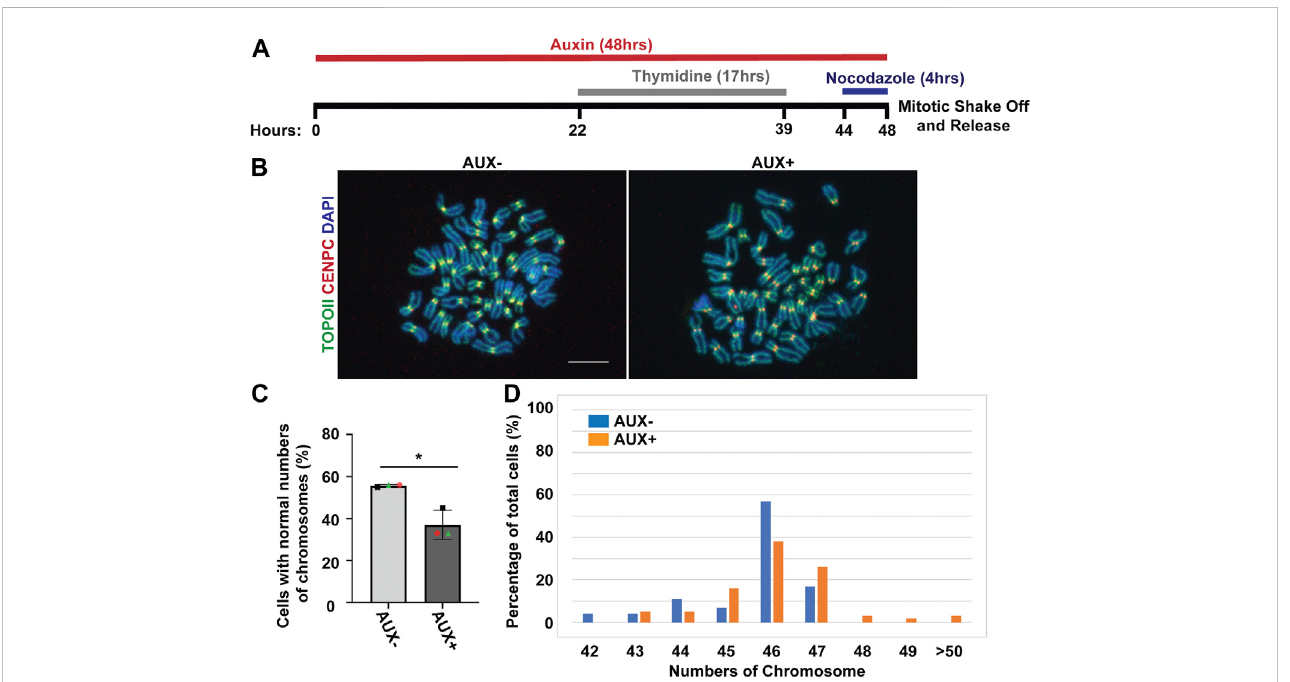
FIGURE 6 The EWSR1 knockdown promotes the induction of aneuploidy. (A) . Schematic diagram for the mitotic synchronization of AID-EWSR1 knockdown (synchronized to mitosis using thymidine/nocodazole, and treated with AUX for 48 h concurrently) cells. The mitotic cells were harvested 30 min after released from the arrest. (B) . Representative images of chromosomes visualized with anti-CENP-C (red), and anti-Topoisomerase II (green) obtained from AUX- and AUX + cells. Scale bar = 10 um. (C) . The percentage of cells that displayed normal 46 numbers of chromosomes was decreased in AUX + cells compared to AUX-cells. 18-24 cells per sample were counted from n = 3 experiments (Total of n = 56 cells from AUX-, and of n = 62 cells from AUX+). Two- tailed paired t-test, * p < 0.05. (D) . The percentage of of cells with each of the chromosome numbers in AUX − and AUX + cells n = 3